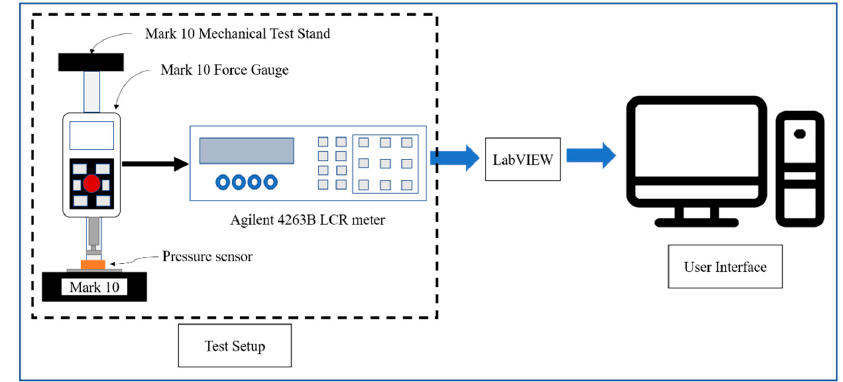
Figure 3. Schematic of the sensor testing set up for electromechanical characterization.